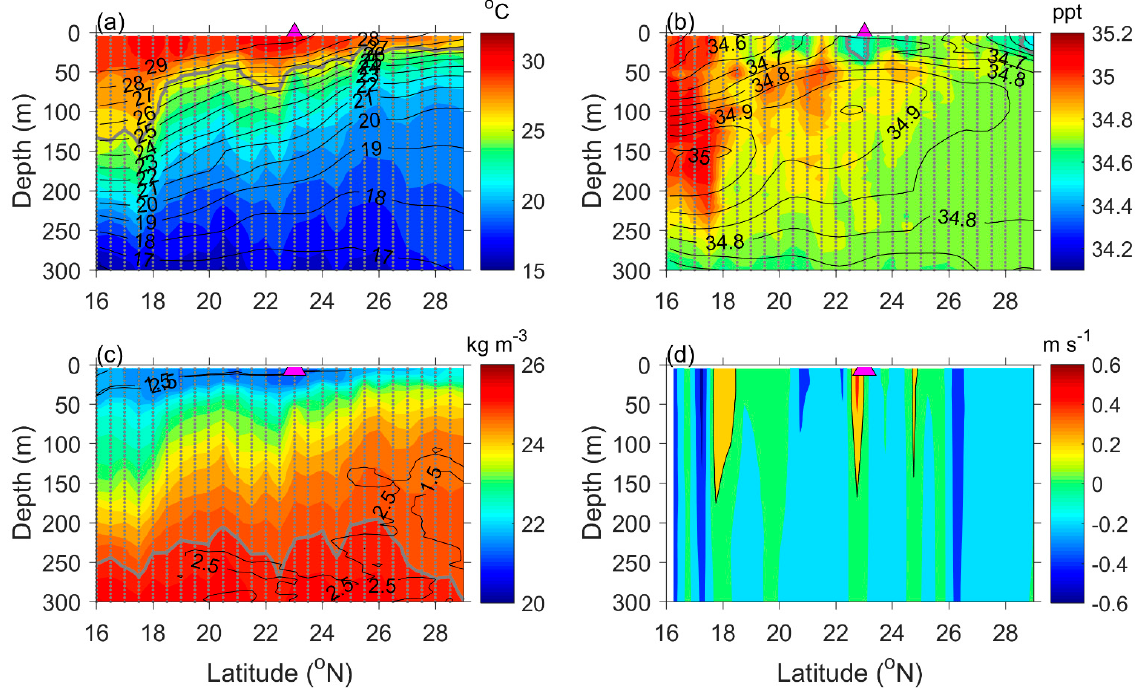
Figure 6. Profiles of ( a ) temperature, ( b ) salinity, ( c ) potential density, and ( d ) zonal geostrophic velocity, measured along the 137° E transect in July 2010. In ( a – c ), bold gray contours show the contour of temperature and salinity at 26°C, 34.6 ppt, and 25 kg m − 3 , respectively. Black thin contours show the July climatological field in ( a , b ), low potential vorticity at 1.5 × 10 − 10 s − 2 and 2.5 × 10 − 10 s − 2 in ( c ), and zonal geostrophic velocity at 0.2 m s − 1 in ( d ). The purple triangles near the surface at approximately 23° N in all figures indicate the location of the CTD station, which corresponds to the purple triangles in the temperature-salinity diagram shown in Figure 5f. Gray dots in ( a – c ) show the location of CTD stations and depth resolution.